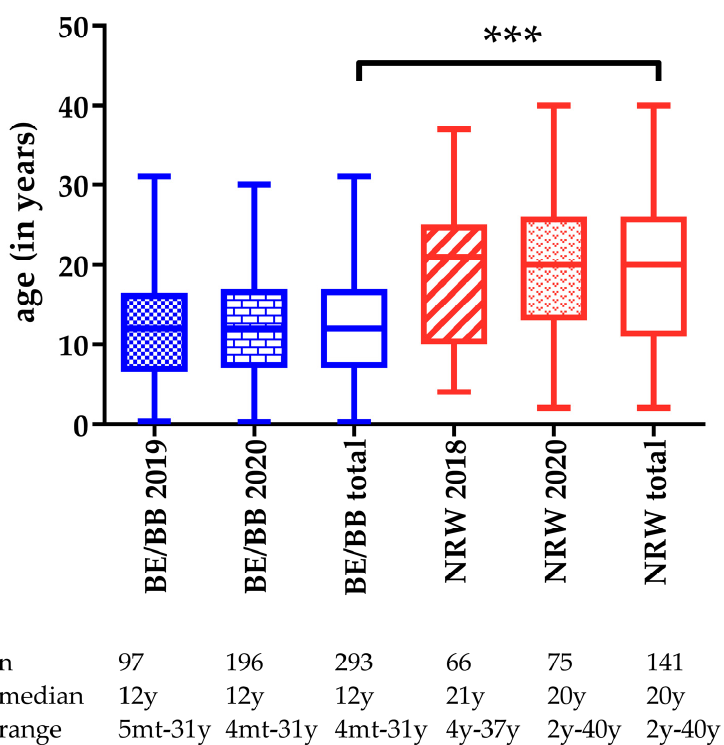
Figure 1. Box plots (median and range) showing the age distribution in the sampled horses from the regions Berlin/Brandenburg (BE/BB) and North Rhine–Westphalia (NRW) ( n total = 434, n in NRW 2018 = 66, n in NRW 2020 = 75, n in BE/BB in 2019 = 97, n in BE/BB in 2020 = 196, for 3 horses the age had not been reported). ***, p ≤ 0.0001; Berlin/Brandenburg (BE/BB) and North Rhine–Westphalia (NRW), mt, months, y, years .